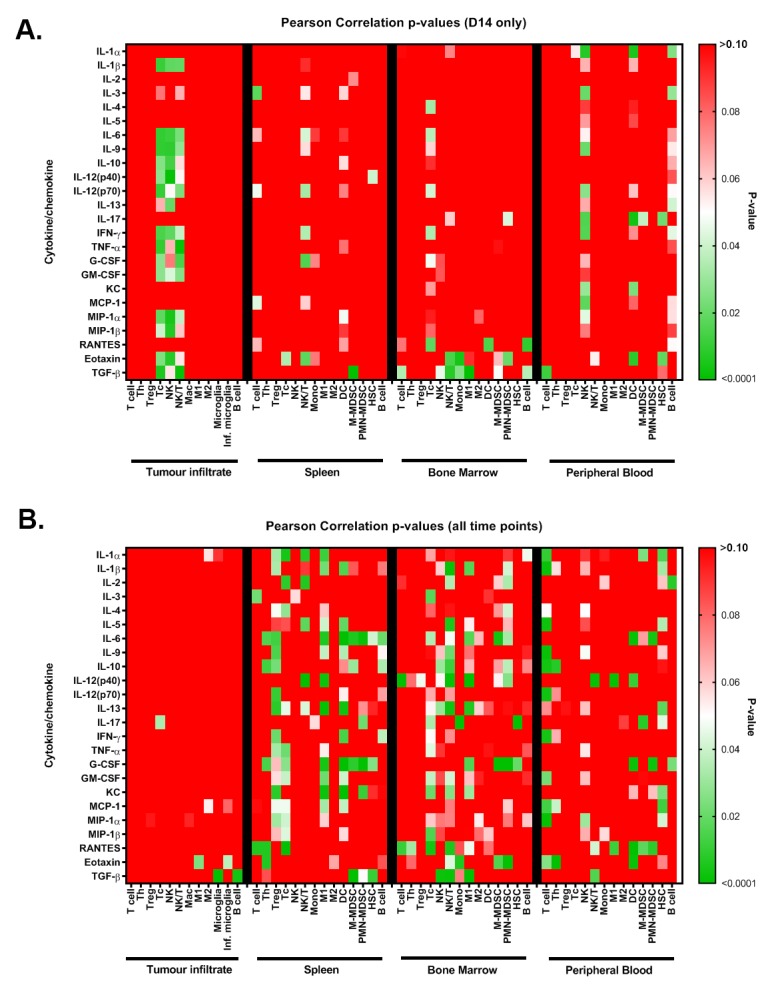
Color maps of the p-values for Pearson correlations between plasma cytokine levels and tumor and systemic immune cell populations at day-14 post-inoculation (A) and at all time points (B). Red, p>0.05, white p = 0.05, green p<0.05.